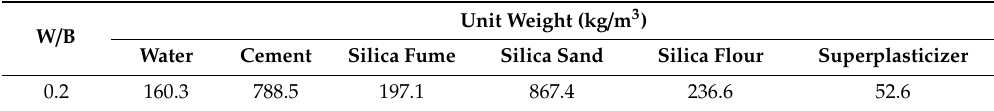
Table 2. Mixture proportions.